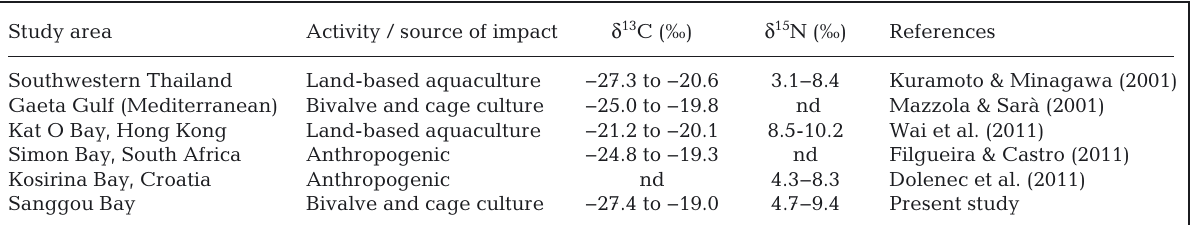
Table 3. Ranges of carbon and nitrogen isotope values of the present study compared to previous values reported in the literature from different coastal areas having aquaculture activities or being impacted by various sources of organic matter. nd: not